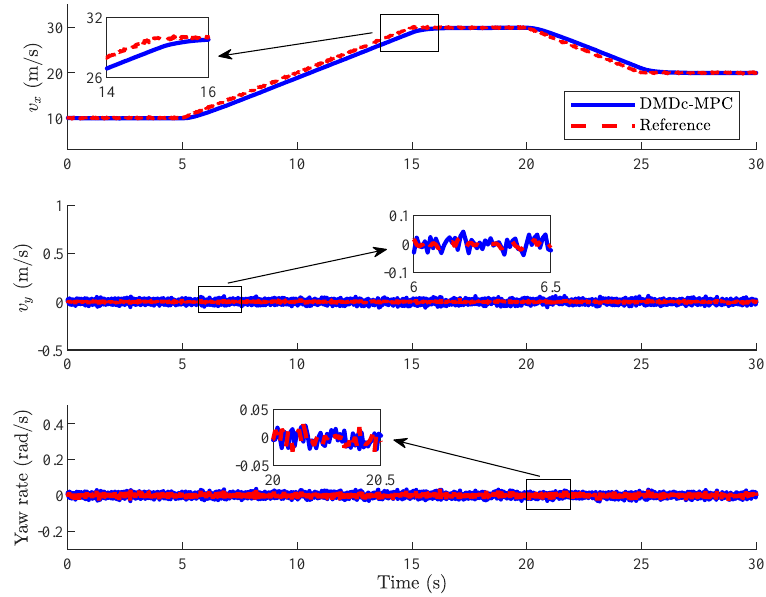
Figure 11. State evolution of DMDc-MPC (Case 1).